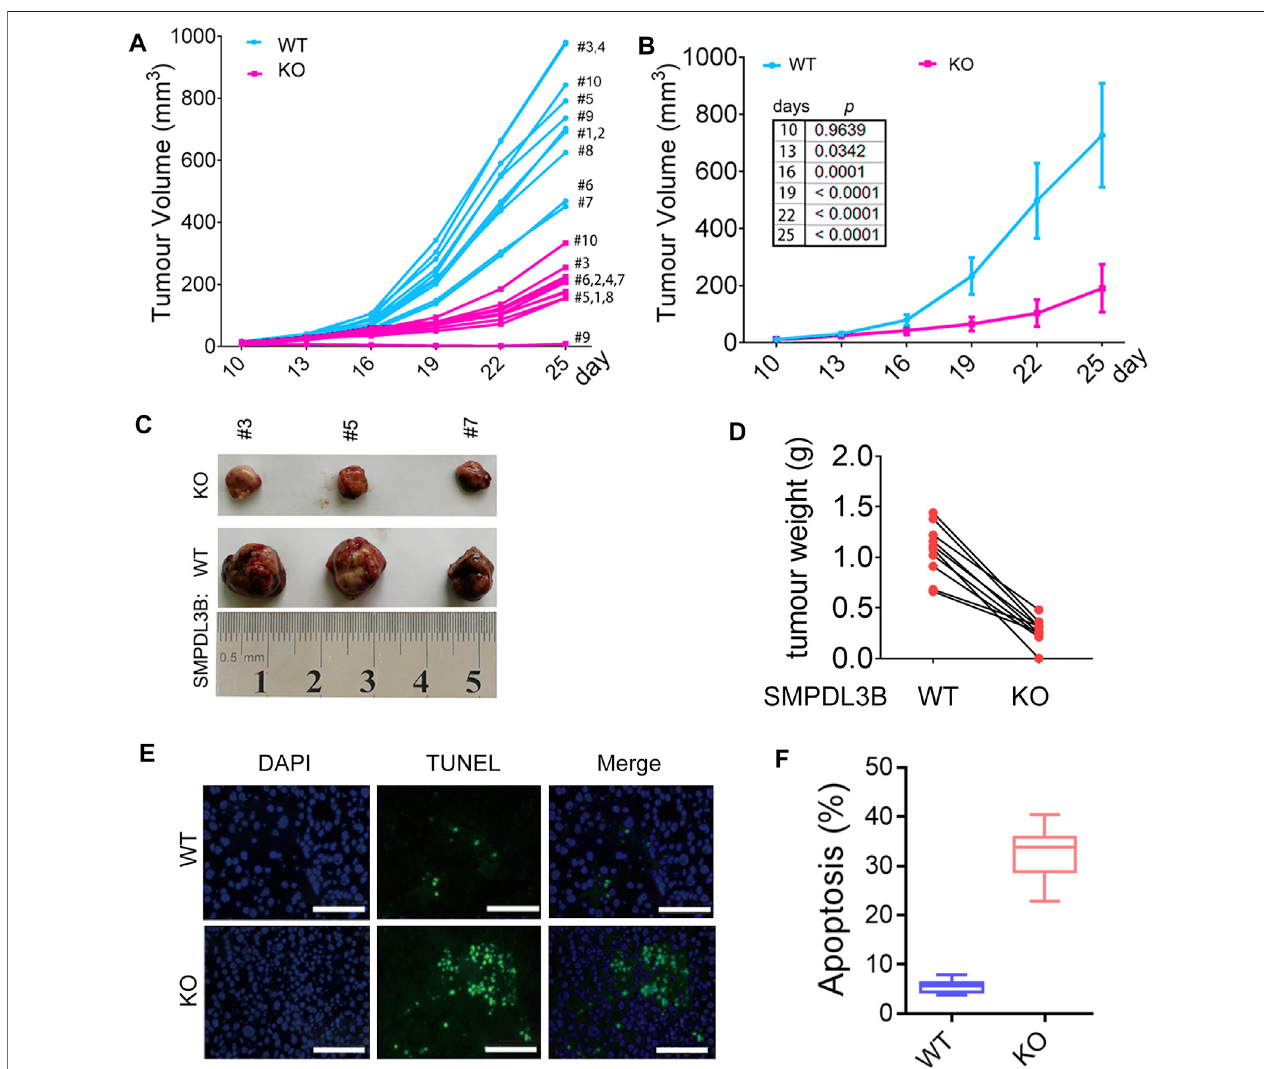
FIGURE 5 | Knockdown of SMPDL3B expression suppressed the growth of AML xenograft tumors in vivo . The nude mice received a subcutaneous injection of SMPDL3B-WT or SMPDL3B-KO Kasumi-1 cells were sacri fi ced on day 25 after injection. (A) The tumor volume of each xenograft at the indicated days after injection was shown. (B) The average volume of the tumor xenografts was shown. Data were presented as mean ± S.D. ( n (cid:1) 10). (C) Representative images of the isolated tumors. (D) Eachpairedweightofthetumorxenograftswasshown( n (cid:1) 10,paired t -test, p < 0.001). (E) RepresentativeimagesoftheTUNELassaysforthetumors were shown (bars, 100 μ M). (F) Percent apoptosis of the SMPDL3B-WT and KO tumors. n (cid:1) 5, mean ± S.D. p <